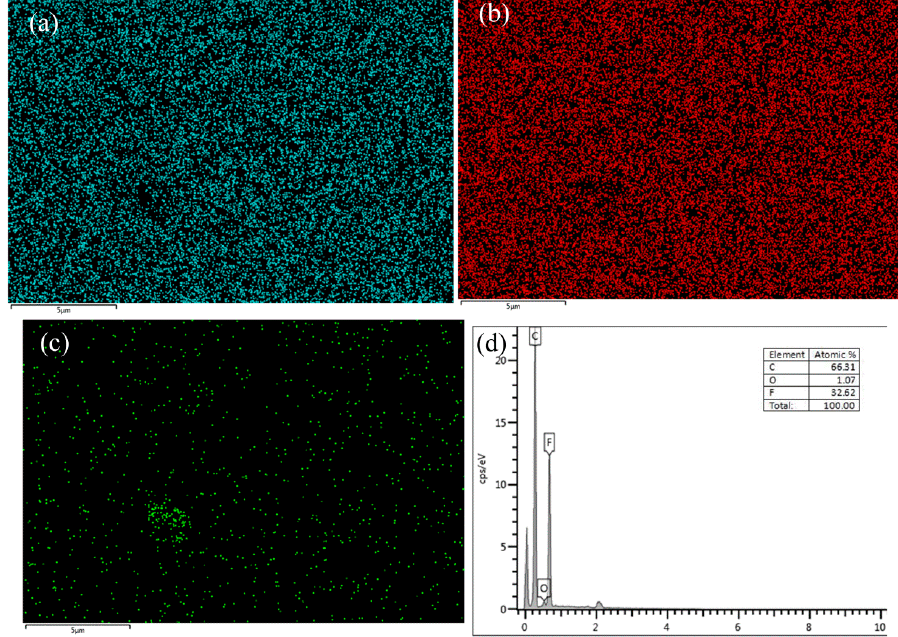
Figure 6. Energy-dispersive spectrometry (EDS) of CB / PVDF composite film (CB content 6.0 wt.%): ( a ) elemental mapping for F; ( b ) elemental mapping for C; ( c ) elemental mapping for O; ( d ) EDS spectrum of CB / PVDF.